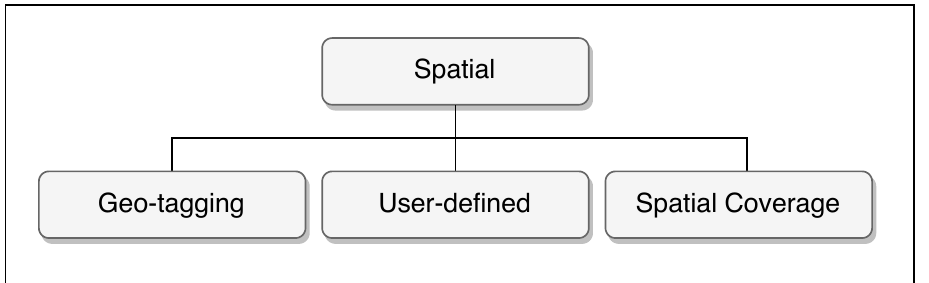
Figure 4. Spatial representation of geographical information on social